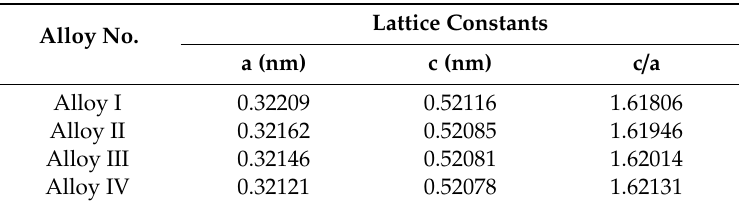
Table 4. Lattice constants of Mg–7Gd–5Y– x Zn–0.5Zr